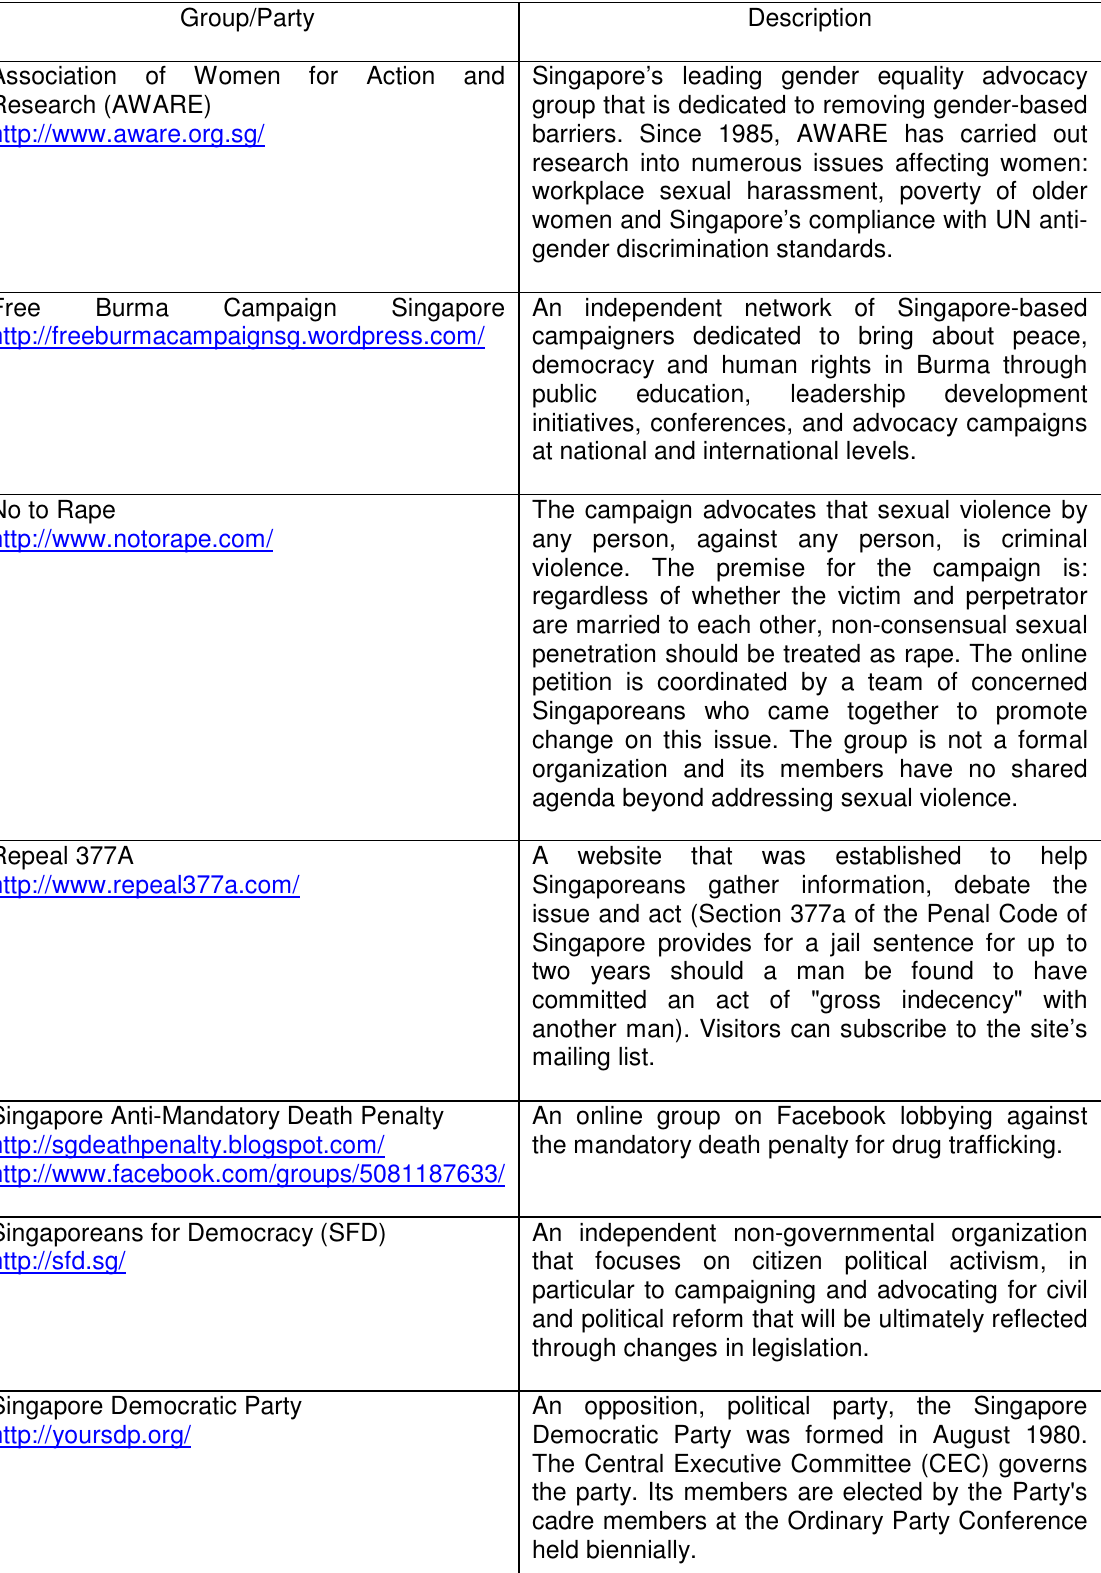
Table 1: Profile of Organizations and